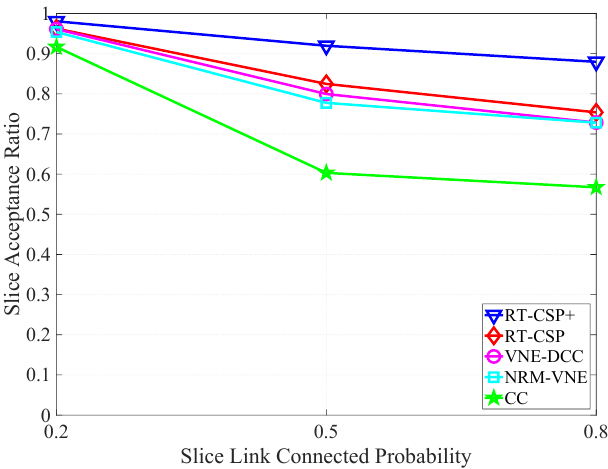
Figure 4. Slice acceptance ratio in the different slice link connected probability scenario.